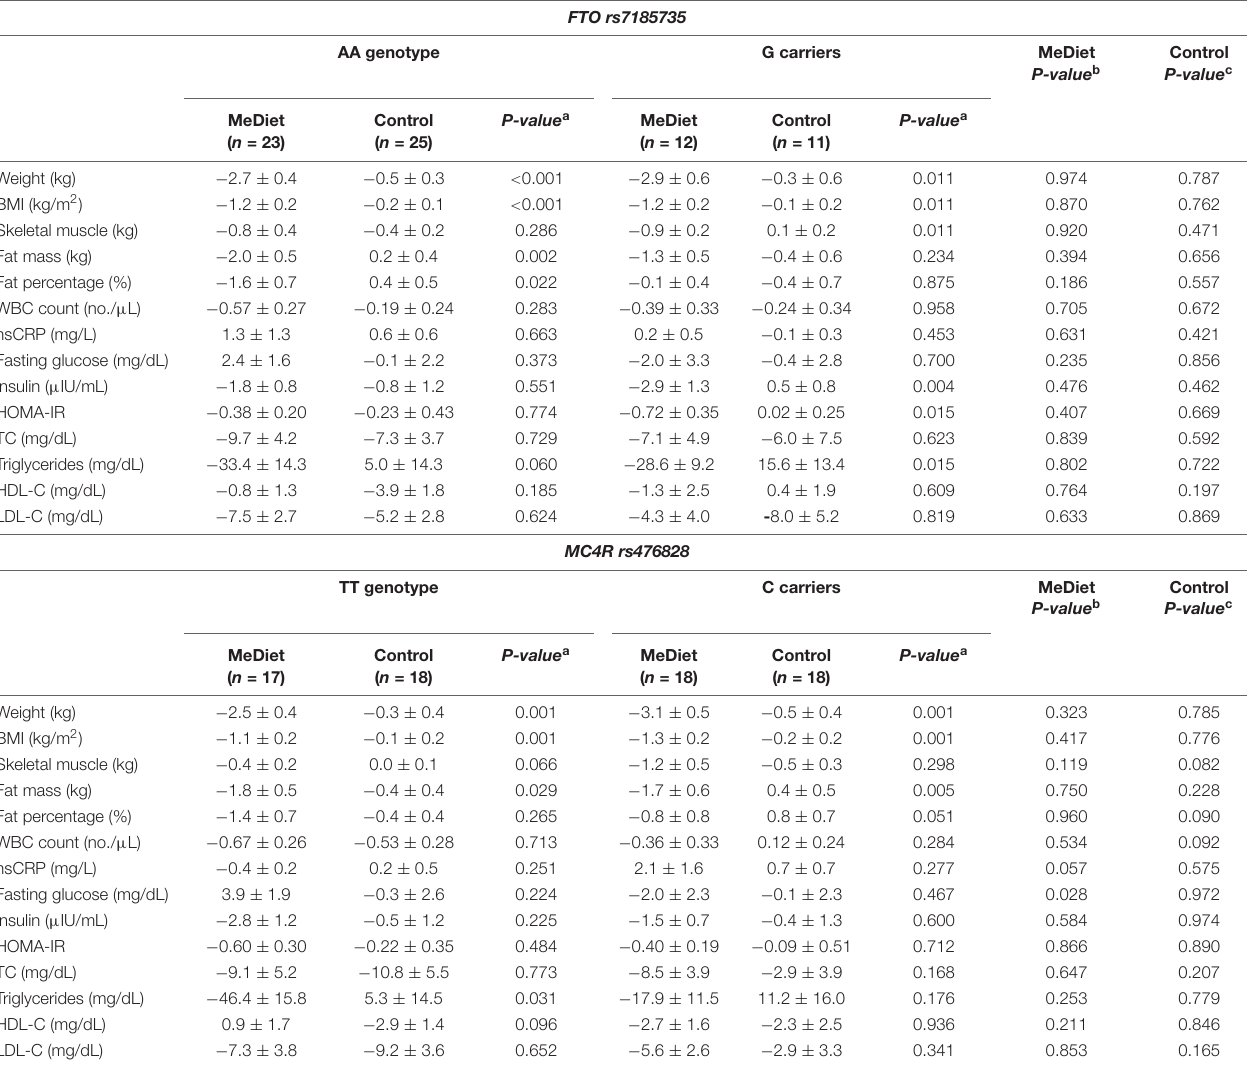
TABLE 3 | Changes in body composition and metabolic parameters after intervention according to